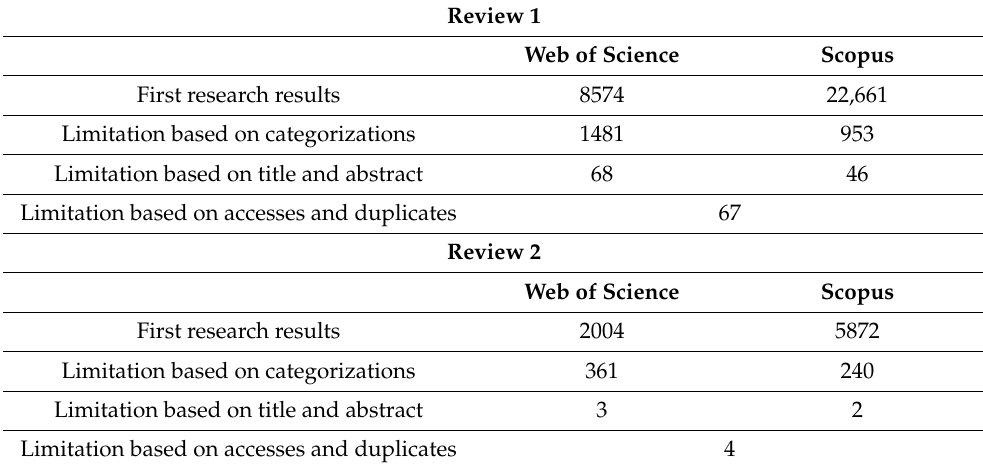
Table A1. Research results per limitation stage.